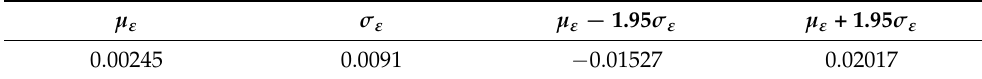
Table 2. Estimation errors of Equation